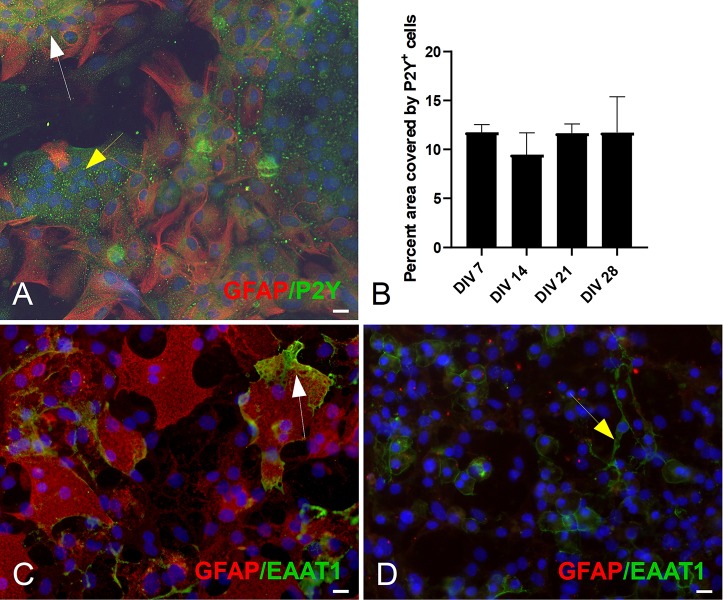
Double ICC staining of mESC derived astrocytes for markers GFAP, P2Y1R. (A) Culture example at DIV 21 of GFAP+ (white arrow) astrocytes and GFAP– cells (yellow arrow) expressing the metabotropic P2Y1R receptor. (B) Quantification of P2Y1R expression: percent (%) area covered by P2Y1R+ cells. (C) Culture example at DIV 21 of GFAP+ (white arrow) expressing the Glutamate Aspartate Transporter (GLAST, also known as EAAT1). (D) Culture example at DIV 21 of GFAP– (yellow arrow) expressing GLAST. Cell nuclei marker H-33342 (blue stain). Scale bars 20 μm.